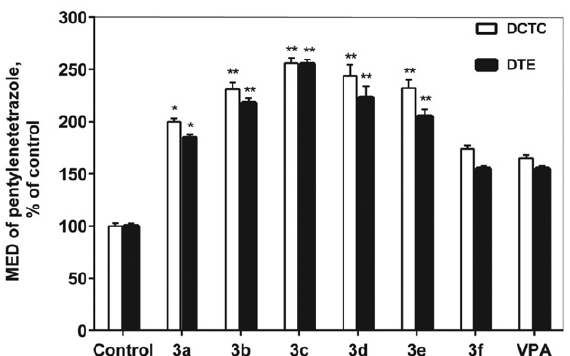
Figure 1 . Anticonvulsant activity of compounds 3a-f at 3 h after oral administration. Values are given as mean ± SEM, n = 5 mice; for all groups p < 0.01 compared with control; * p < 0.05 and ** p < 0.01 compared with VPA